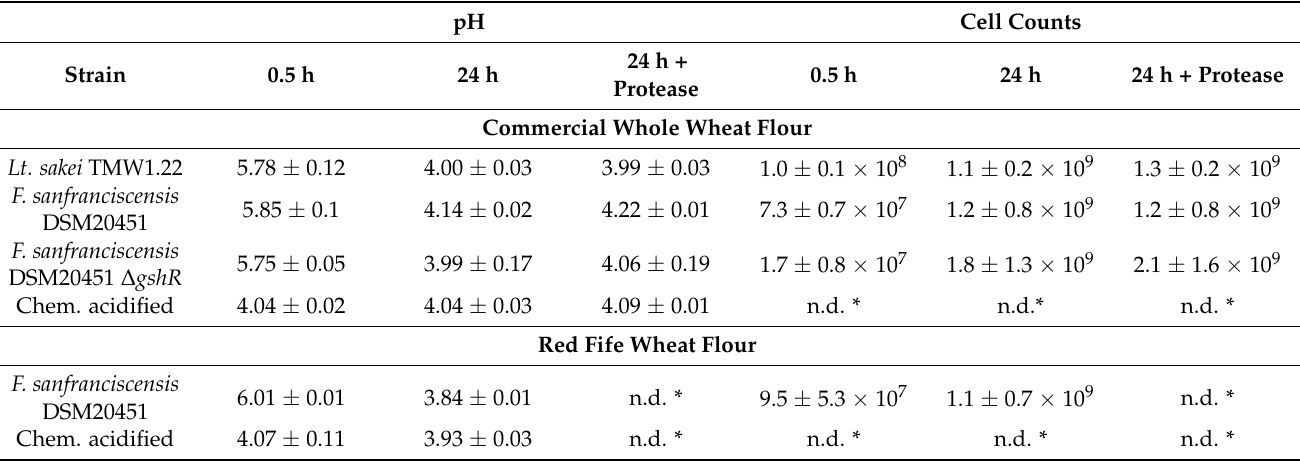
Table 1. pH and cell count of sourdoughs with commercial whole wheat flour and Red Fife wheat flour ( n = 3 biological